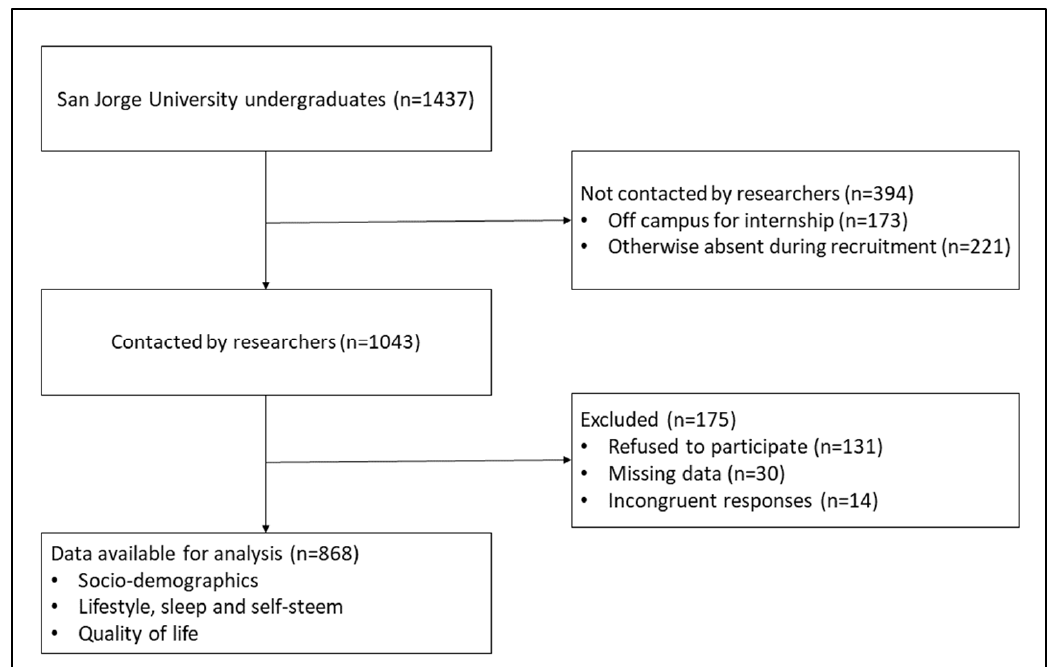
Figure 1. Study flowchart.